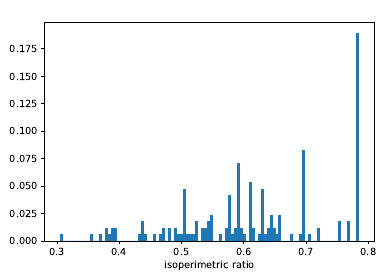
Figure 10. Histogram of isoperimetric ratio